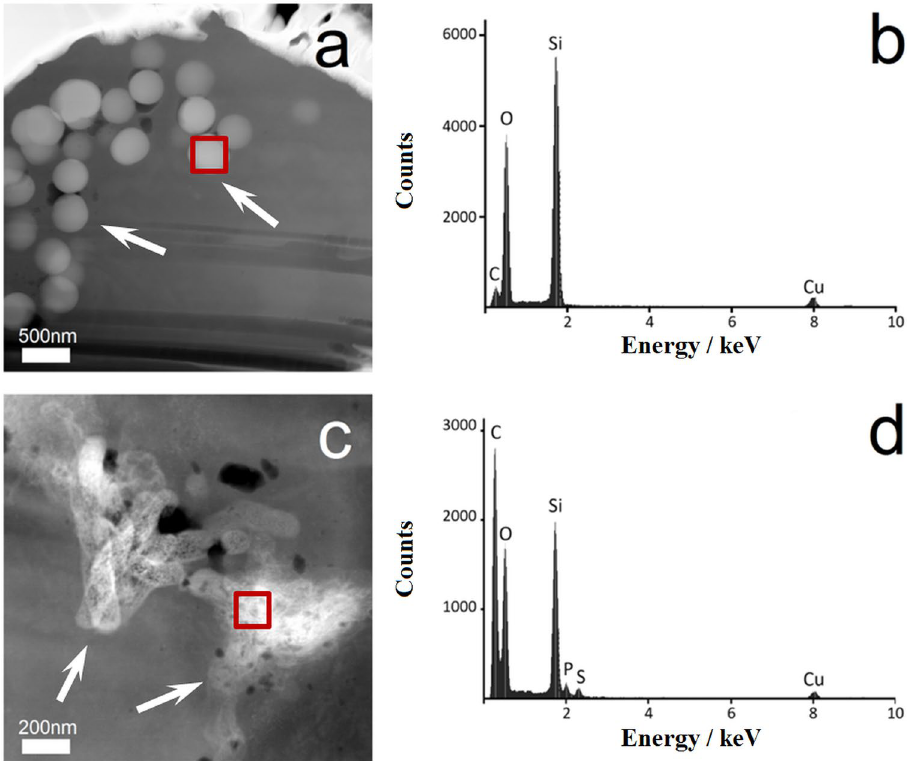
Figure 6. Representative TEM/EDX analyses of FIB-prepared cell lamellae from single NR8383 cells after 24 h of exposure to 100 µg mL −1 unfunctionalized silica particles. The thickness of each TEM lamella was 100 nm. TEM images of cell lamellae were prepared after incubation with microspheres ( a ) or microrods ( c ); white arrows indicate particles inside the cells. Corresponding EDX spectra ( b and d ) of the elements detected within the regions of interest of the cell lamellae (red boxes in a and c ) confirmed the presence of